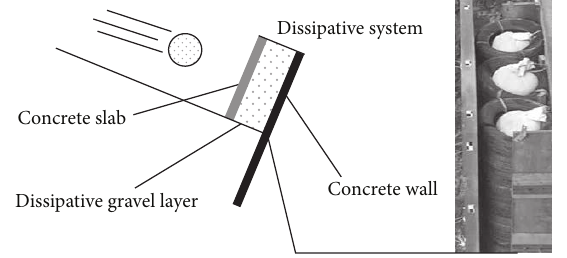
Figure 2: Sandwich cushion structure.